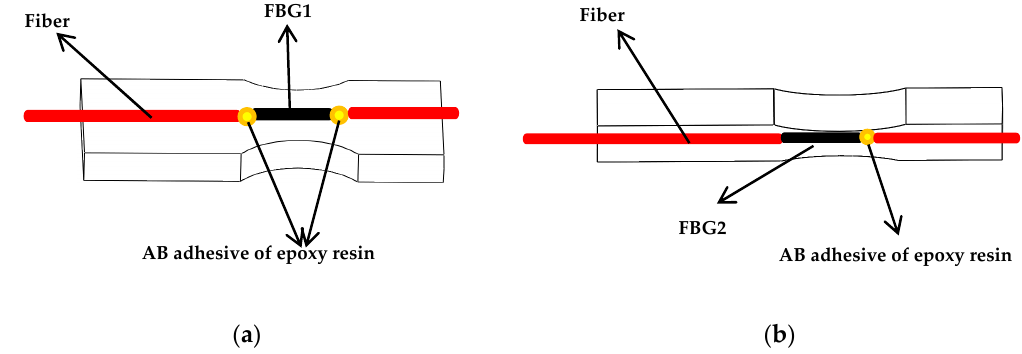
Figure 8. Two pasting methods of FBG1 and FBG2: ( a ) Two ends of FBG1 are pasted on the new type of elastic beam; ( b ) One end of FBG2 is pasted to the new type of elastic beam.